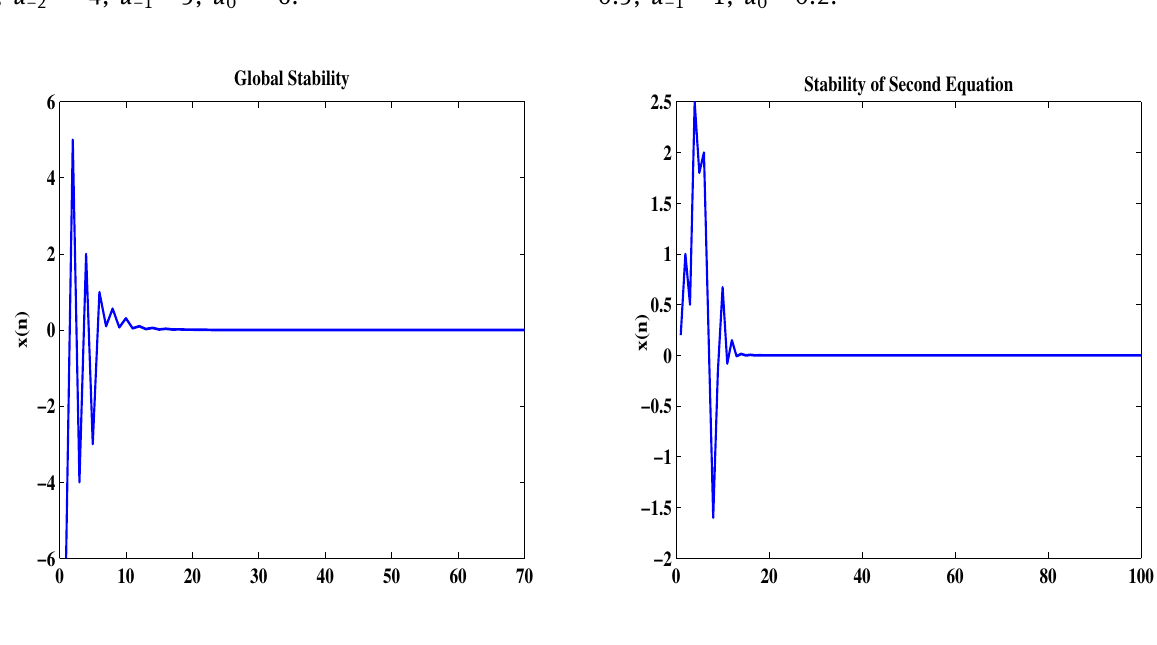
Figure 4: Stability of the